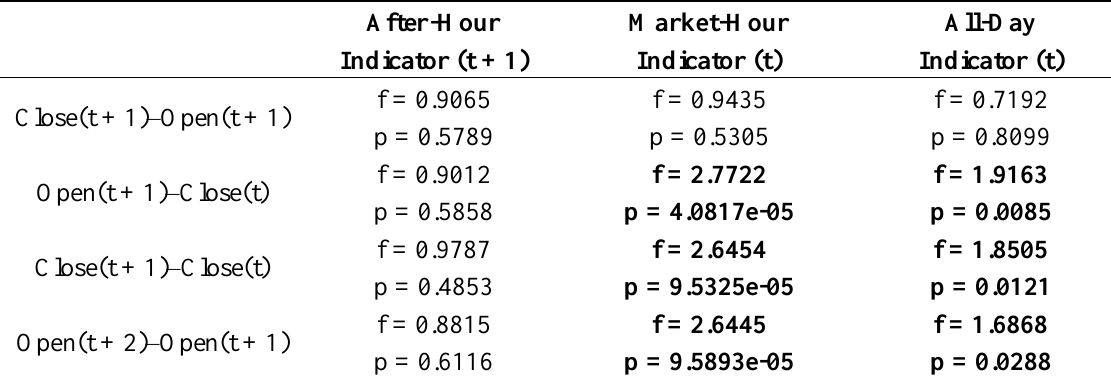
Table 5. Granger causality test on the all-day/market-hour/after-hour indicators. Test statistics that are significant at the 10% level are in